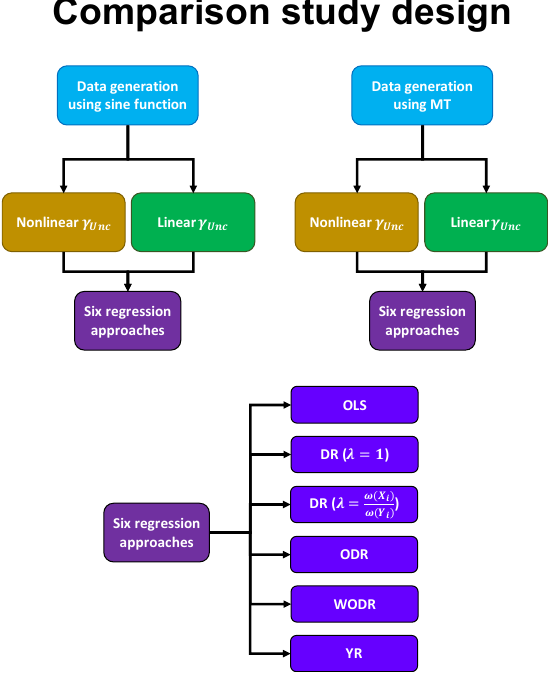
Figure 3. POC comb and EC true data generated by the sine functions of Chu (2005). (a) Time series of the 120 data points for POC comb and EC true . (b) Scatter plot of POC comb vs. EC true .